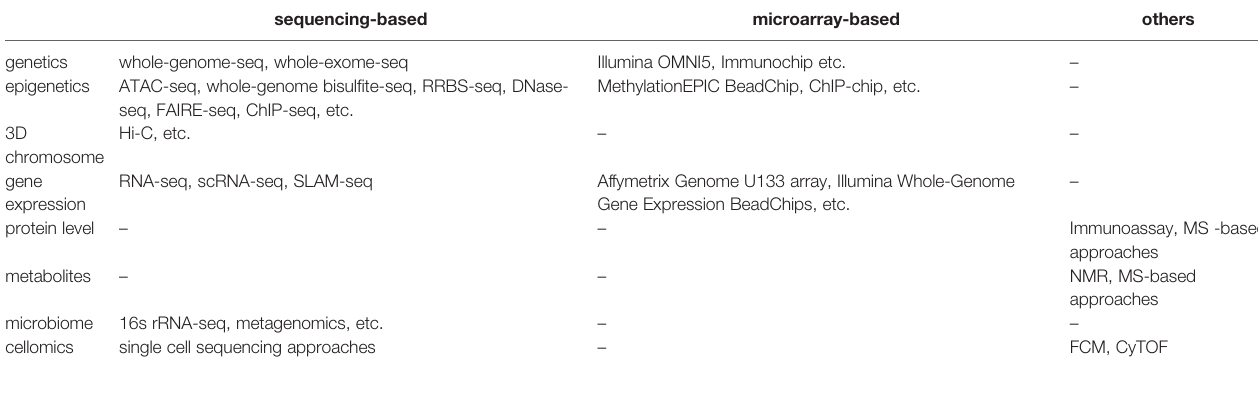
TABLE 1 | Typical approaches in omics